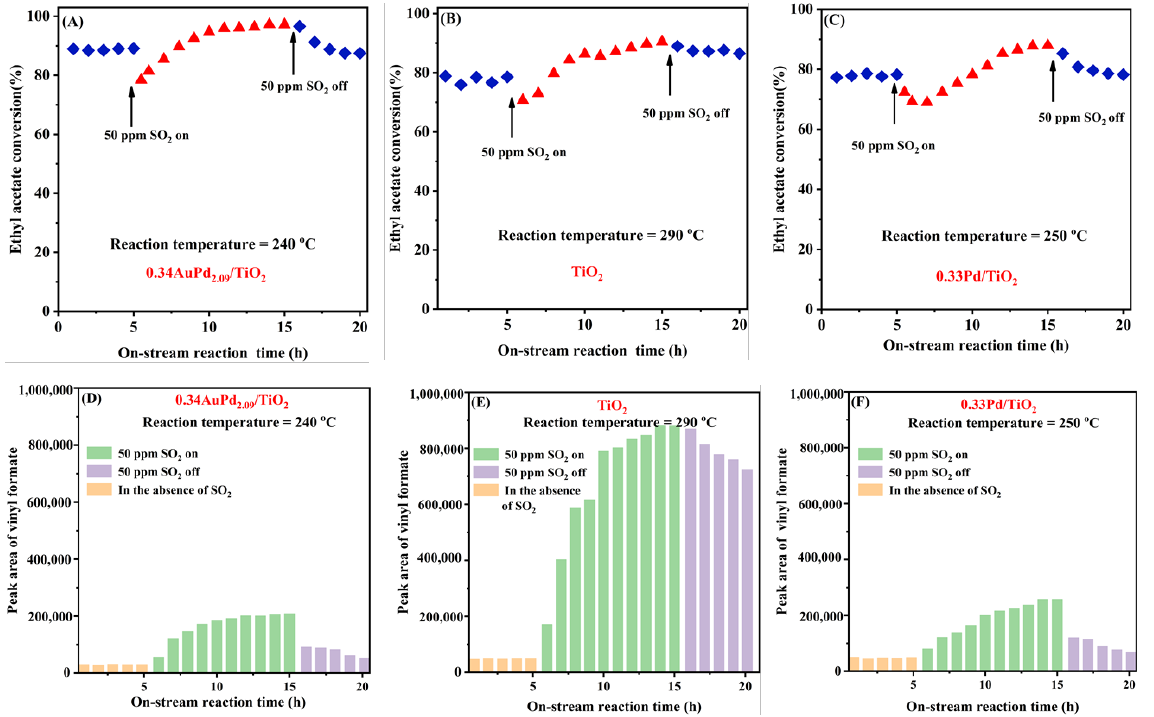
Figure 8. Effect of 50 ppm SO 2 on ( A – C ) catalytic activity and ( D – F )intermediate selectivity of the ( A , C ) 0.34AuPd 2.09 /TiO 2 , ( B , E ) TiO 2 , and ( C , F ) 0.33Pd/TiO 2 samples for ethyl acetate oxidation at SV = 40,000 mL/(g h).